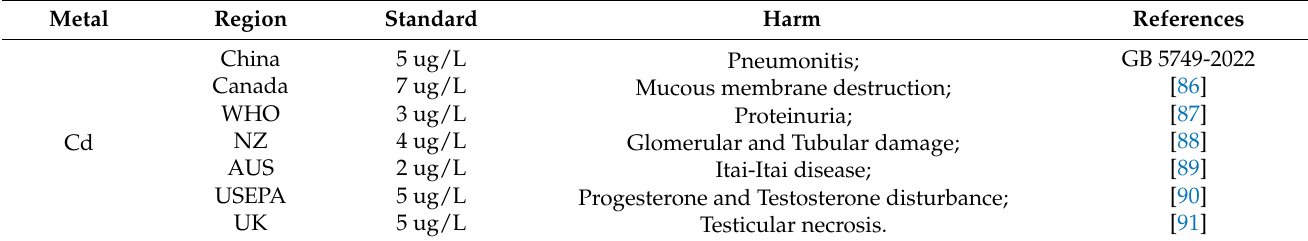
Table 6. Control standard of Cd in different areas and harm of